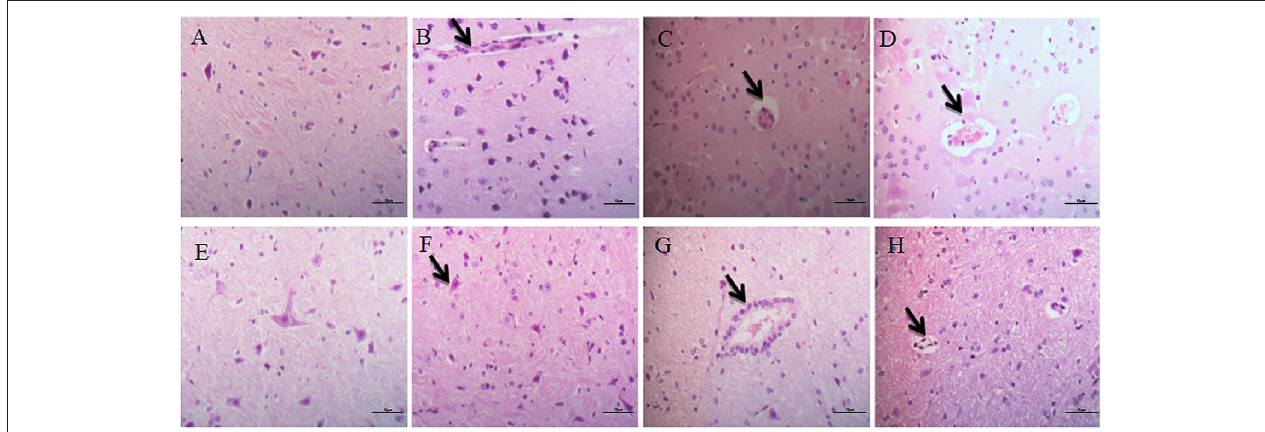
FIGURE 3 | Histopathological alterations in the brain. (A–D) Represent changes in the cerebrum of control group, low-dose group, middle-dose group, high-dose group ( × 400); (E–H) represent changes in the cerebellum of control group, low-dose group, middle-dose group, high-dose group ( × 400). The black arrow masks edema and slight neuronophagia (B–D) , vacuolization of purkinje cells (F–H)